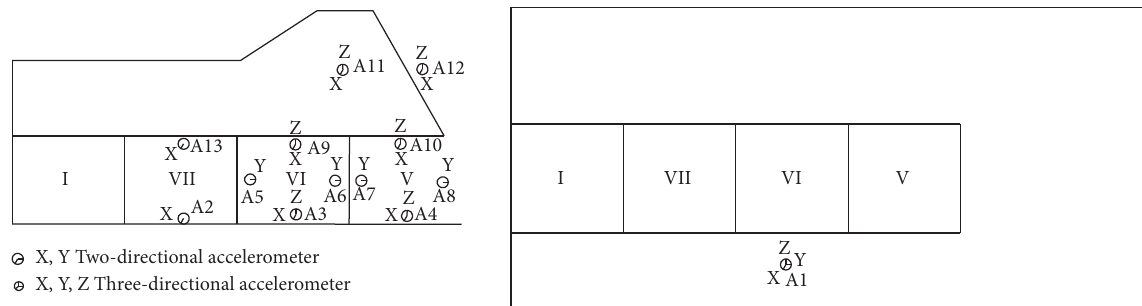
Figure 11: Schematic diagram of the longitudinal section and bottom of the elliptical tunnel opening